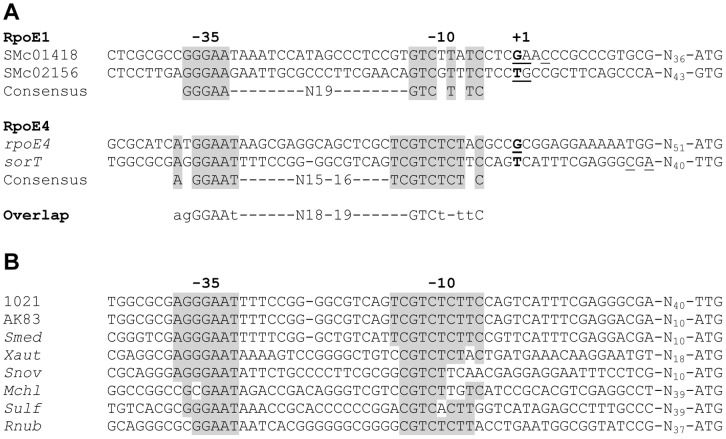
Promoter regions of various genes.A. Transcription start sites (+1) in promoter regions of S. meliloti genes controlled by RpoE1 and/or RpoE4, as determined from 5′RACE experiments in the present study (underlined) or deduced from Illumina- or 454-based RNAseq analyses (bold; [41]; Brice Roux, unpublished results). The deduced −10 and −35 sequences recognized by the sigma factors are highlighted in grey. Distance (in nucleotides) to the predicted translation start site of each ORF is indicated. B. The 5′ untranslated region of genes encoding known or putative sulfite-oxidizing enzymes from S. meliloti AK83, S. medicae WSM419 (Smed), Xanthobacter autotrophicus Py2 (Xaut; two identical sequences), Starkeya novella DSM506 (Snov), Methylobacterium chloromethanicum (Mchl), Sulfitobacter sp. EE-36 (Sulf; identical sequence in Sulfitobacter sp. NAS-14.1) and Roseovarius nubinhibens ISM (Rnub) are aligned with the sorT promoter region of S. meliloti 1021. Conserved putative −10 and −35 regions are highlighted in grey. See Fig. S4 for further details.